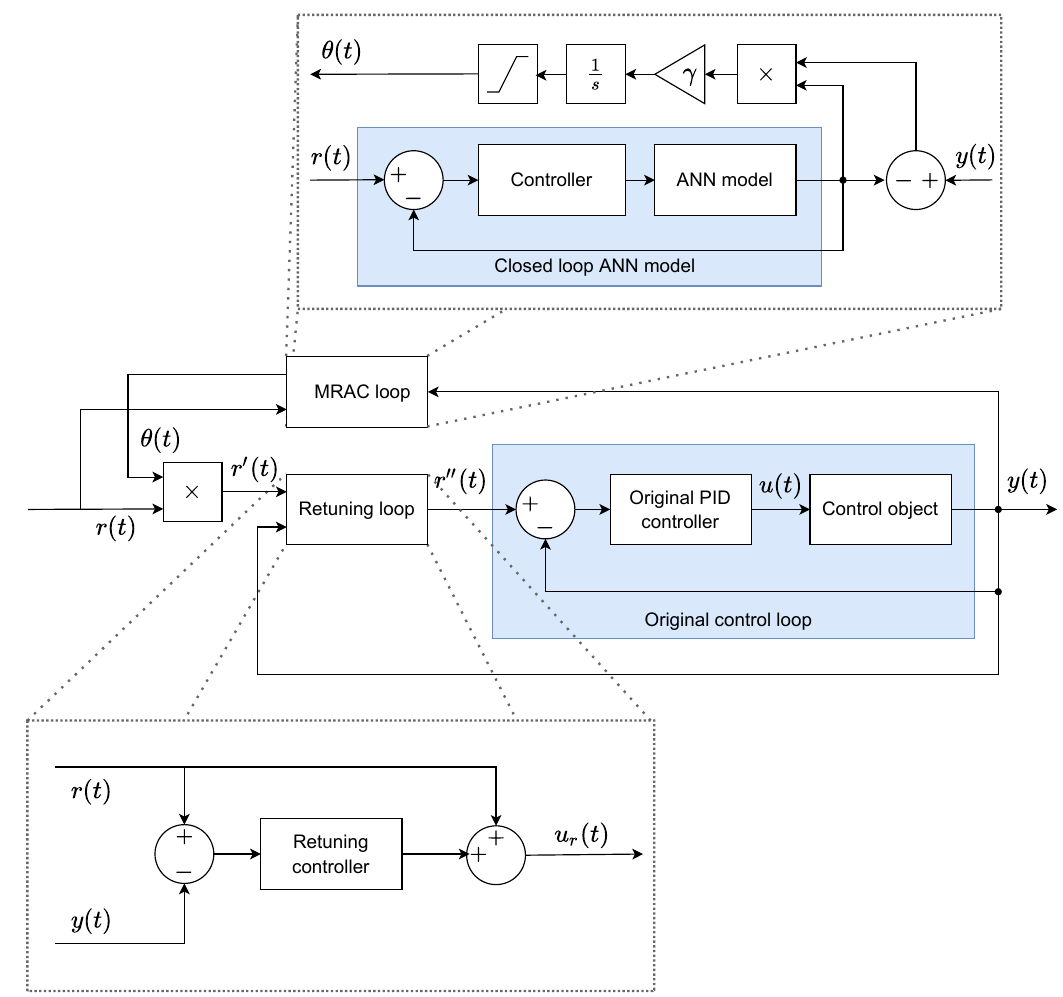
Figure 11. Complete experimental configuration for evaluating the multi-loop control structure. There are three control loops in total: the original PID control loop with reference input r (cid:48)(cid:48) ( t ) , the retuning loop with reference input r (cid:48) ( t ) that replaces the dynamics of the original loop with those of the optimally tuned FOPID controller, and the MRAC loop to which the original reference input r ( t ) is connected. By bypassing reference inputs in various ways, it is possible to achieve different simulation scenarios with the MRAC loop and retuning control loop enabled or disabled independently. This schematic diagram serves as the basis for both pure software simulations and real-time experiments in MATLAB/Simulink